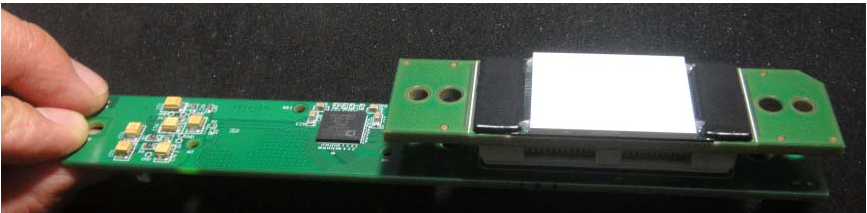
Figure 2. Photo of the modular detector unit.